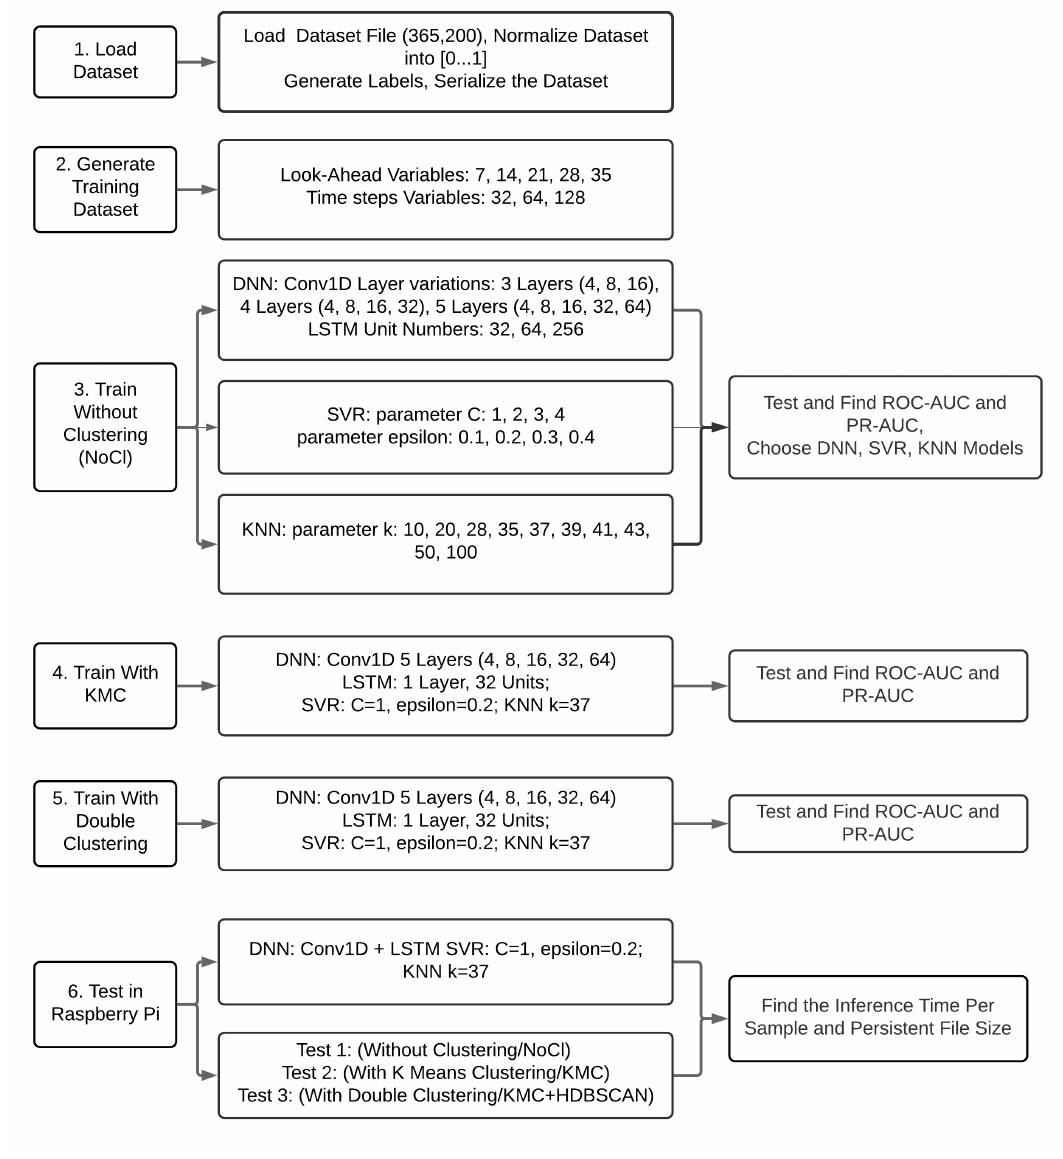
Figure 11. Experimental Setup